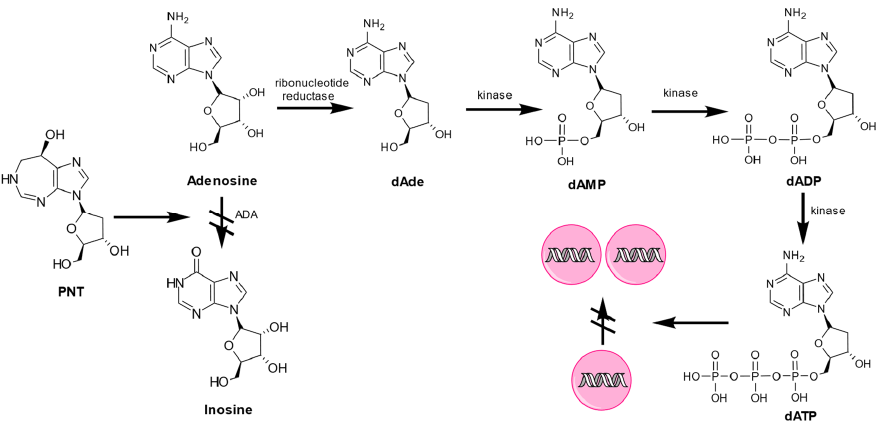
Figure 2. The action mechanism of